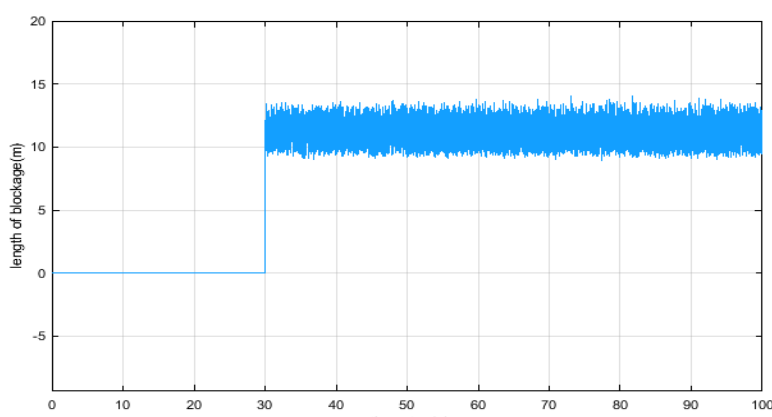
Figure 6. Position of blockage.